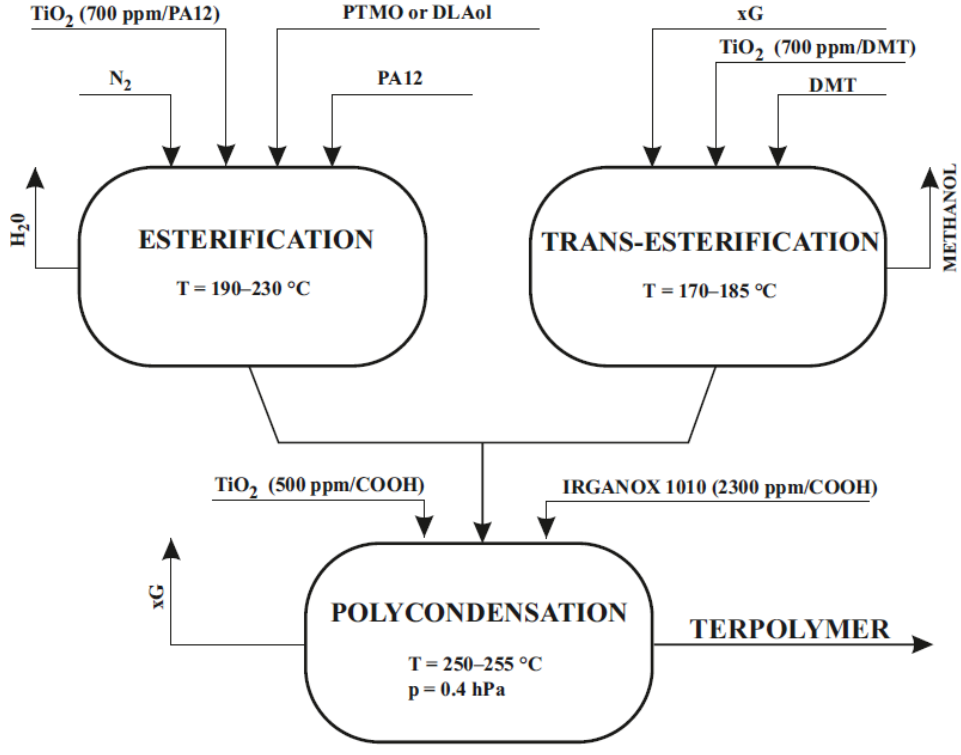
Figure 2. Synthesis of thermoplastic elastomers (TPEs).